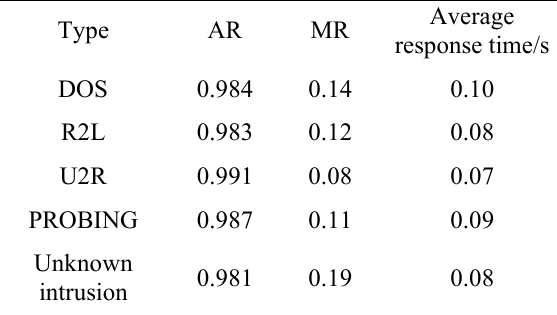
Table 7. Simulation